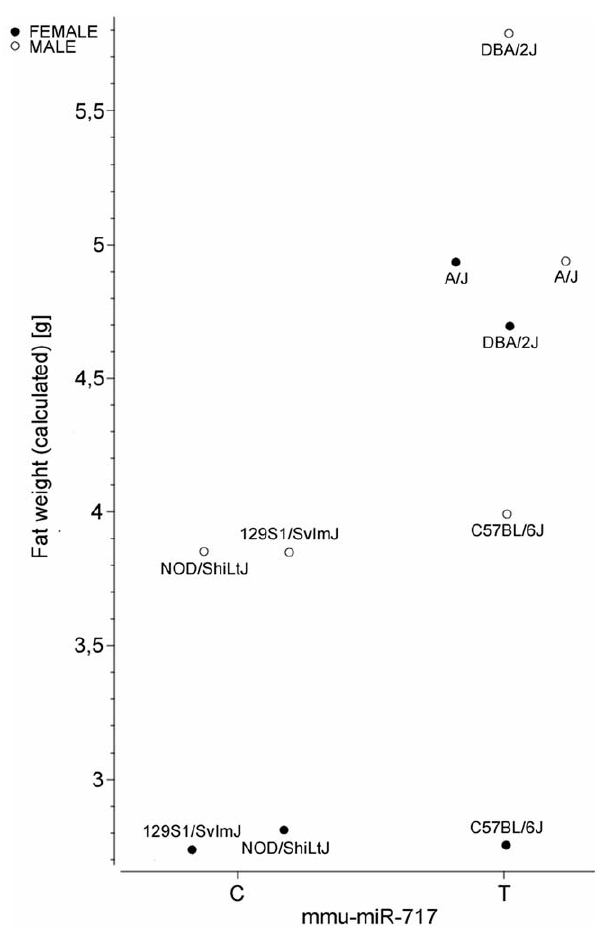
Figure 4. MiR-seed-SNP within mmu-miR-717 is associated with fat weight in mice. Association analysis between mmu-miR-717 SNP genotypes in different inbred mouse strains and phenotypes within the Mouse phenome database revealed that mmu-miR-717 significantly affects several different traits. An example of significant difference between lean and high fat strains that differ for mmu-miR-717 SNP genotype (C . T) and fat weight, for both female and male is shown.